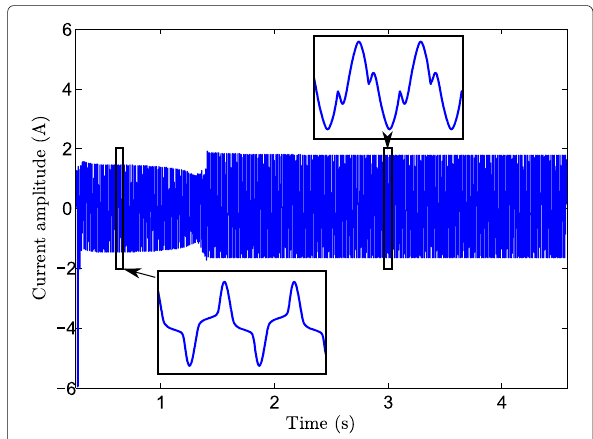
Fig. 19 Turn-on transient current of a microwave